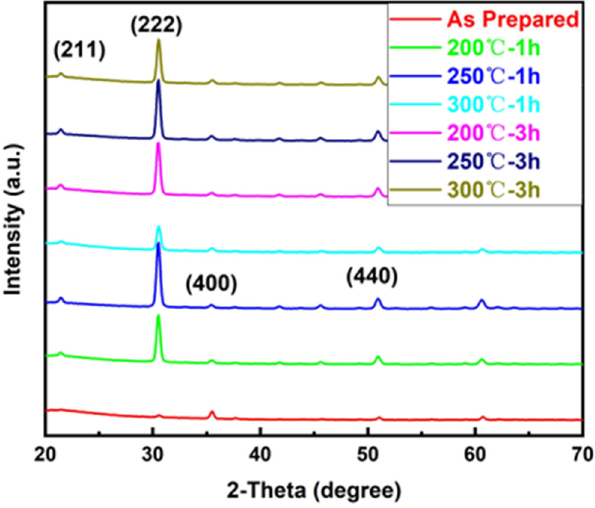
Figure 2. XRD patterns of the prepared In 2 O 3 :H films after annealing at different temperatures and times.